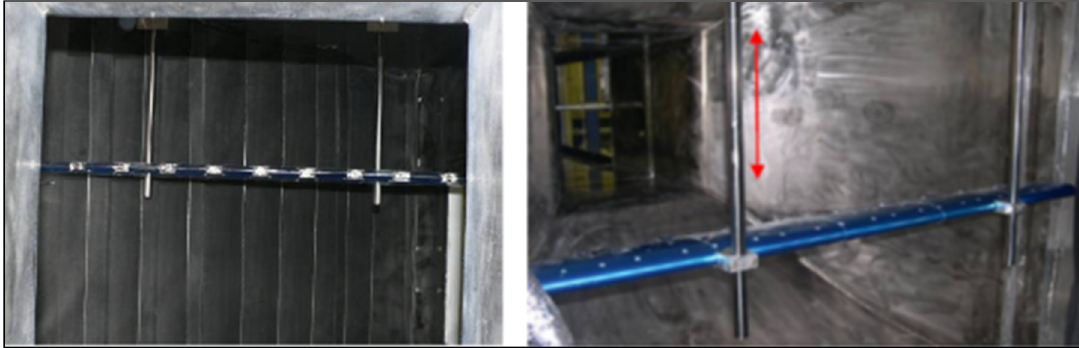
Figure 2. Sprinkler Ramp.